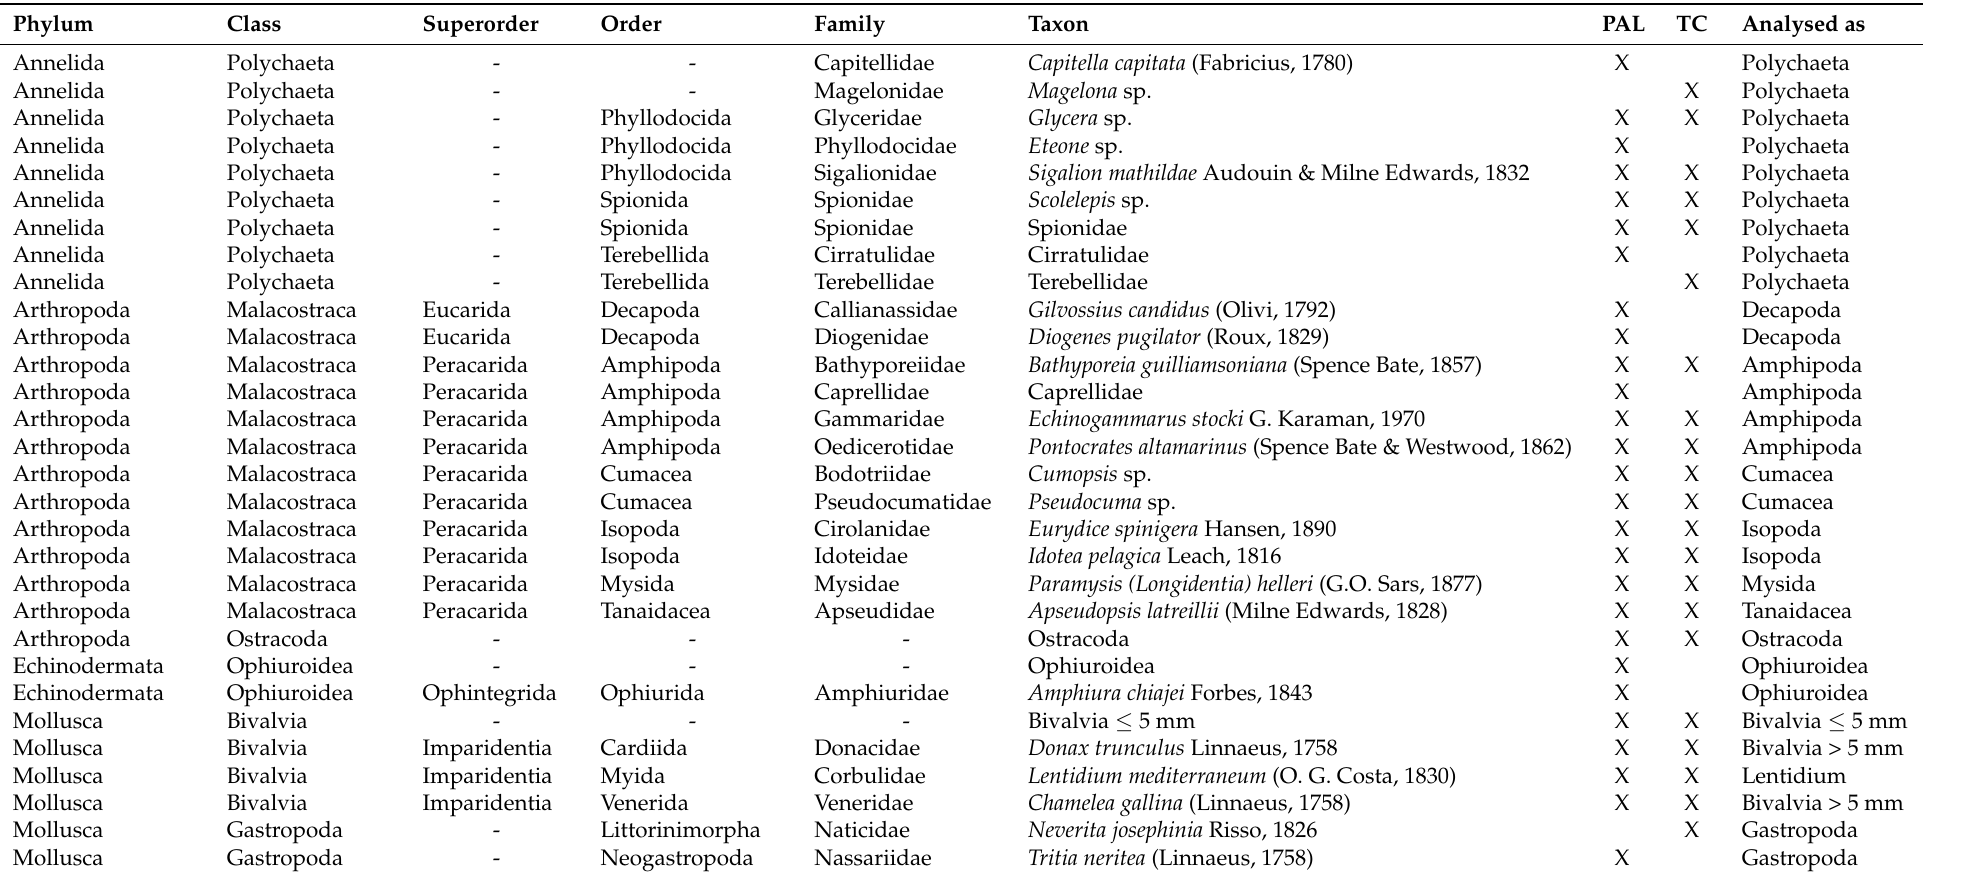
Table 1. List of living-component items detected in the samples; PAL = Palombina; TC = Torre Cerrano. The last column indicates main taxa considered for data